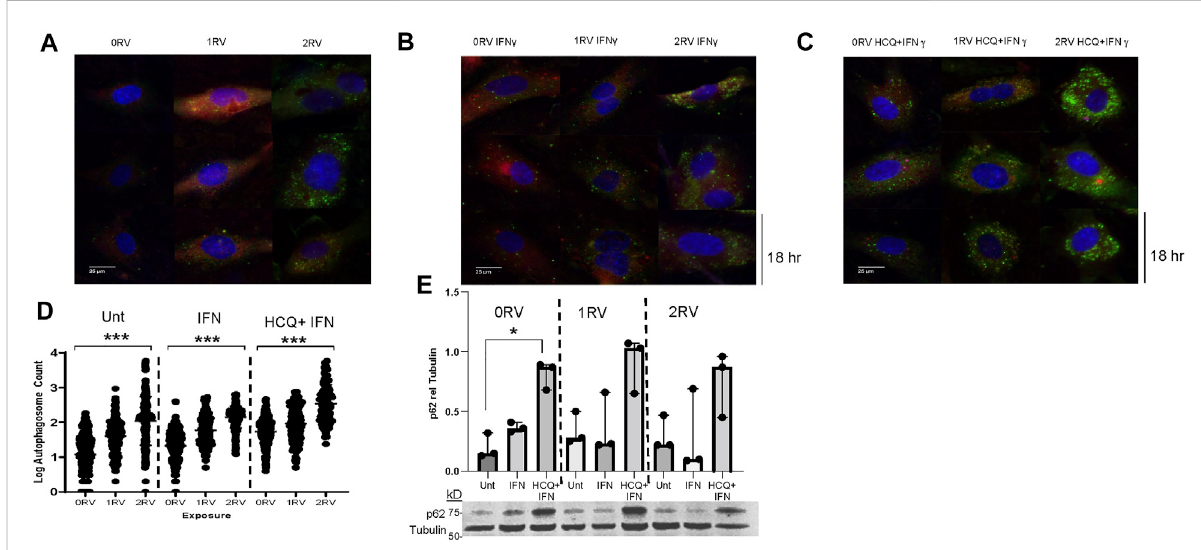
FIGURE 5 APOL1 risk variant-carrying HUVECs display autophagic fl ux de fi ciencies. APOL1 risk variant-carrying HUVECs display autophagic fl ux de fi ciencies. Assessment of autophagosome accumulation using SQSTM1 (p62) staining, a proxy for autophagic fl ux inhibition. (A) Representative immuno fl uorescence images of untreated HUVECs stained for SQSTM1 (p62) across APOL1 genotype. Green FITC positive puncta represent p62- positiveautophagosomes.Tubulincounterstainisrepresentedinred:0riskvariants(RV)(leftcolumn),1RV(middlecolumn),2RV(rightcolumn). (B) Representative immuno fl uorescence images of IFN ɣ (50 pg/ml)-exposed HUVECs (C) Representative immuno fl uorescence images of IFN ɣ plus HCQ (25 µM)-exposed HUVECs. (D) Log transformed values of p62 positive puncta per cell ( y axis) and the exposure condition ( x axis) are shown. HUVEC genotype is labeled from left to right. (E) Immunoblot of HUVEC lysates showing p62 protein concentration compared to tubulin loading control by genotype and exposure condition. Quanti fi cation of experiments are done in triplicate (median + IQR) shown above. HUVECs were treatedfor18 h. p valueswerecalculatedfromKruskal – Wallisone-wayanalysisofvarianceforcrossgenotypecomparisons.Wheremodelsrejected the null hypothesis, a post-hoc 2 group analysis was performed. * represents p value < 0.05, ** represents p value < 0.01, *** represents p value <